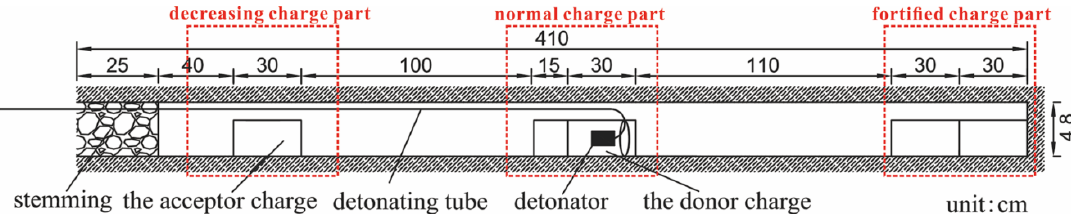
Figure 6. The new charging structure designed using the critical distance.